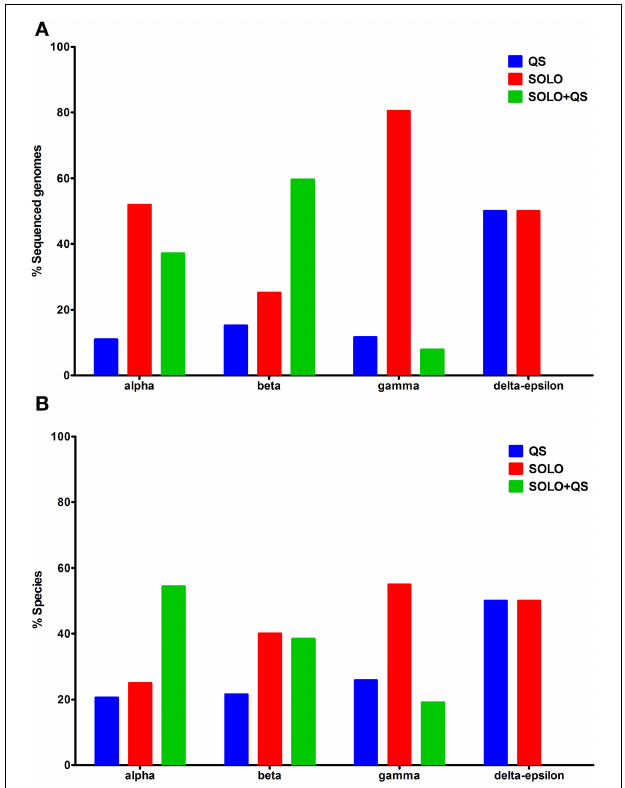
FIGURE 1 | Distribution of QS domain LuxRs in different bacterial classes. (A) Percentage of sequenced genomes carrying QS domain LuxR proteins from each class, having QS LuxRs alone, LuxR solos alone, or both (B) Percentage of species carrying QS domain LuxR proteins from each class, having QS LuxRs alone, LuxR solos alone, or both. QS domain LuxR protein sequences were sourced from Interpro database, IPR005143. On the x-axis, alpha-Alphaproteobacteria, beta-Betaproteobacteria, gamma-Gammaproteobacteria, and